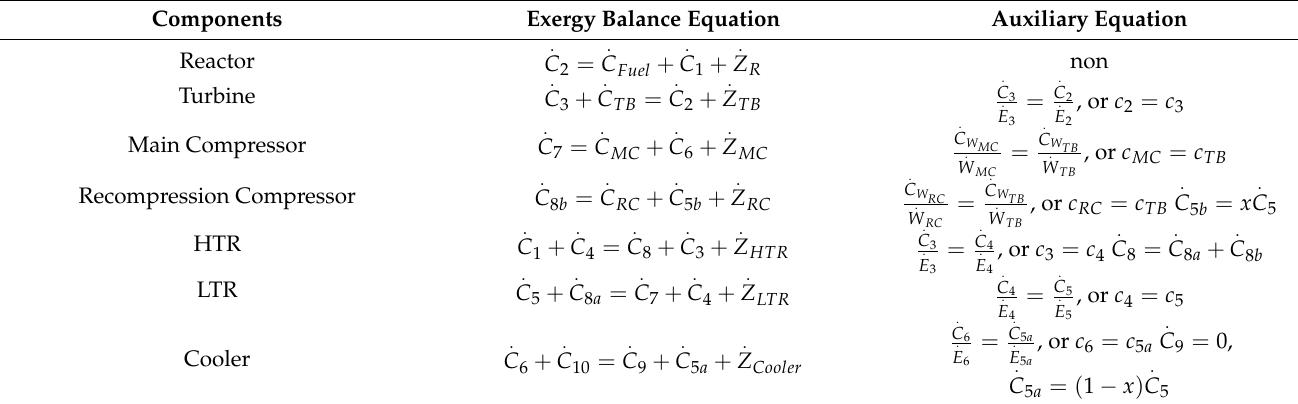
Table A3. Exergy balance for system different components and required auxiliary equations.